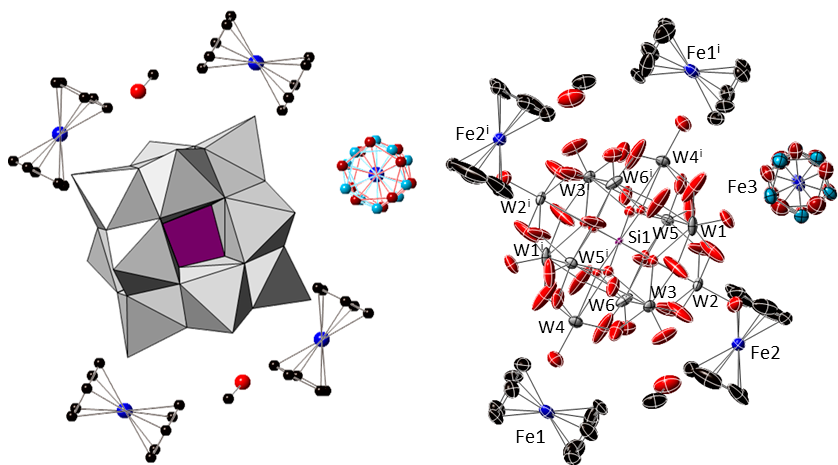
Figure 2. Combined polyhedral/ball-&-stick representation ( left ) and ORTEP view with 50% probability displacement ellipsoids ( right ) of the formula unit of 1 . Colour code: W and {WO 6 } octahedra, grey; Si and {SiO 4 } tetrahedron, purple; Fe, blue; C, black; O, red. The two positions over which the Cp ligands of the Fe3 unit are disordered are depicted in brown and light blue. Hydrogen atoms are omitted for clarity. Symmetry code: (i) 1 − x , − y , 1 − z .